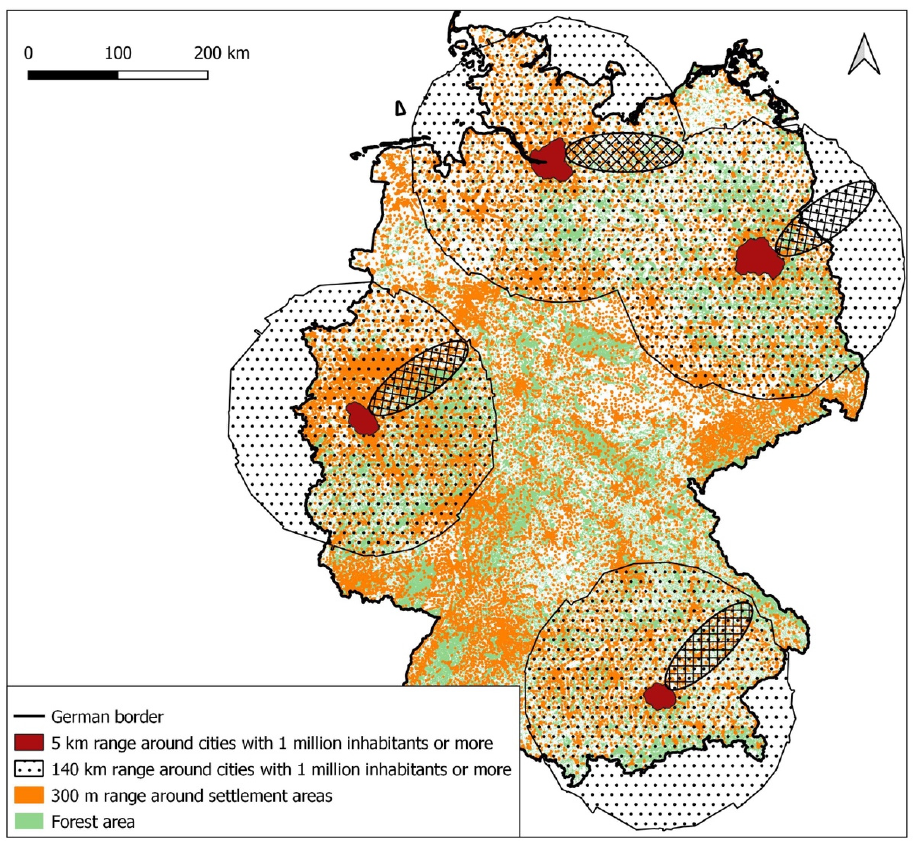
Figure 3. Exposed cities with 1 million inhabitants or more in Germany and fallout contours with wind directions from southwest and west. wind directions from southwest and